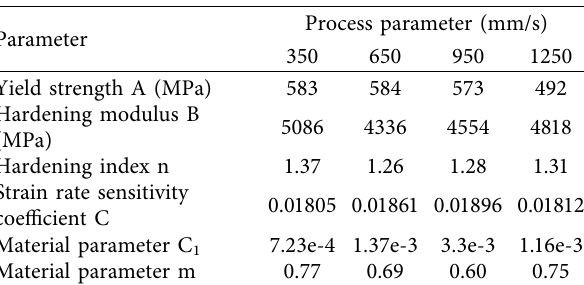
Figure 10: Morphology of the molten pool perpendicular to the laser scanning plane. (a) 350mm/s, (b) 650mm/s, (c) 950mm/s, (d) 1250mm/s. Table 2: Parameters of the J-C constitutive model.